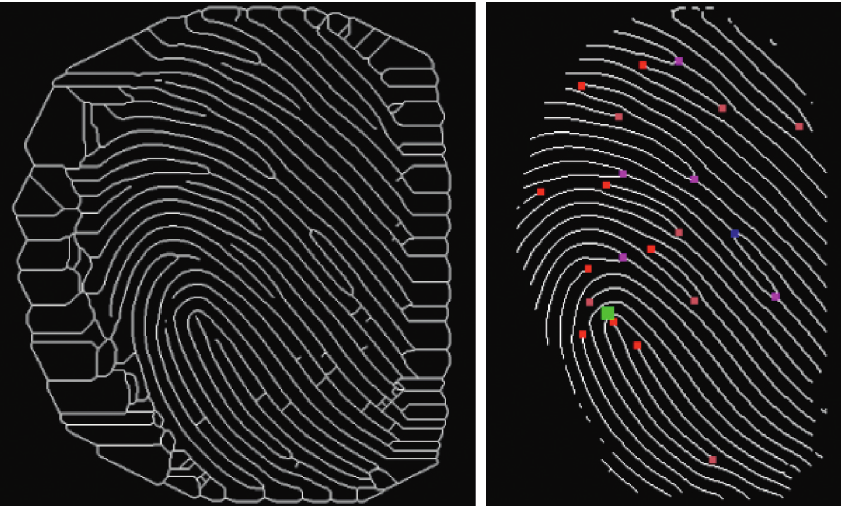
Figure 15: Thinned image (left) and display of minutiae